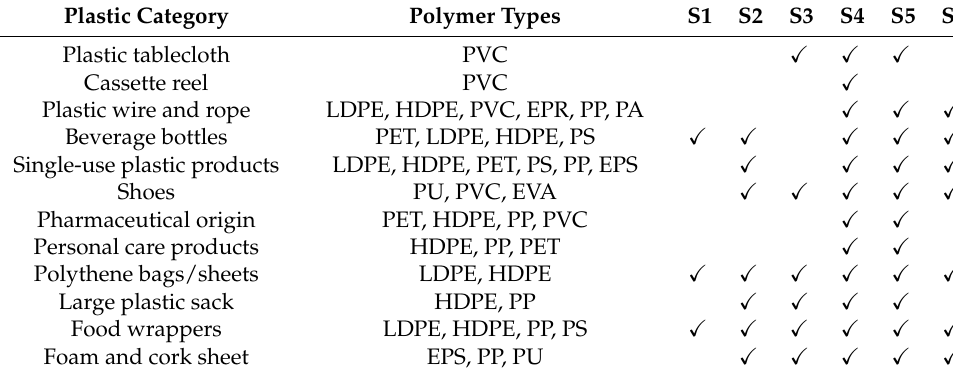
Table 4. Categorization of macroplastics item polymer types [2,13] and availability at different sampling sites.